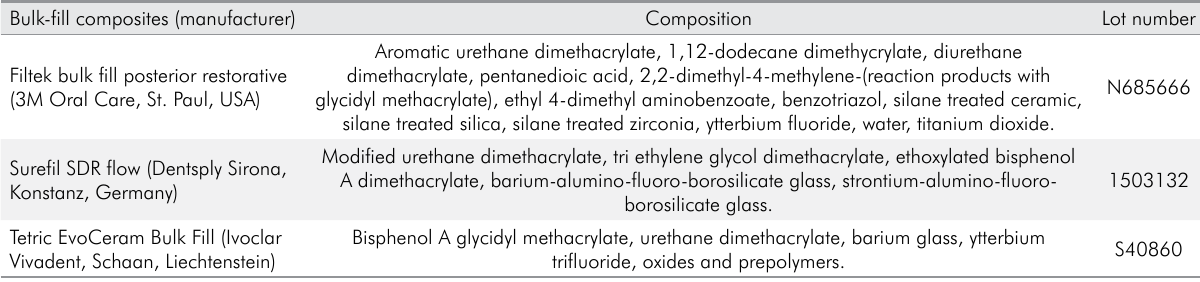
Table 1. Composition and batch numbers. Bulk-fill composites